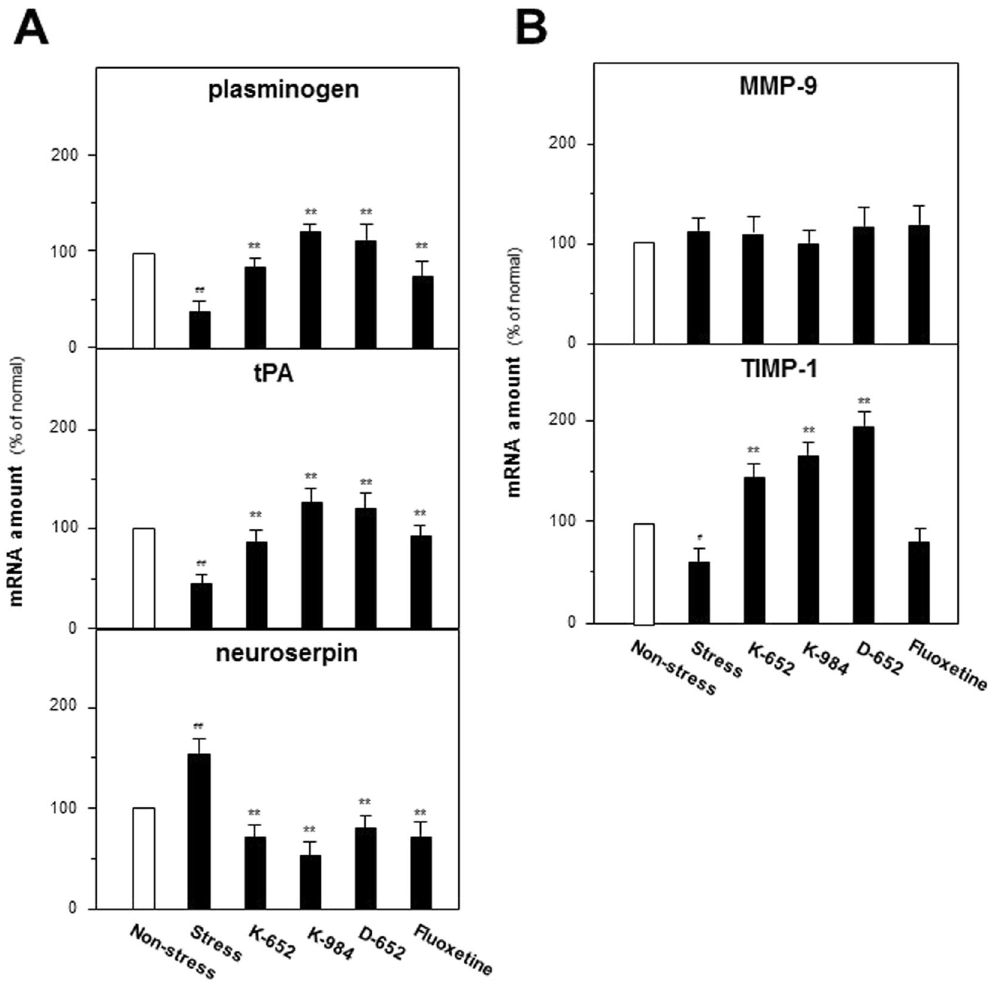
Figure 5. KXS series formulae regulate mRNA expressions of proteins relating to metabolic pathway of neurotrophic factors in hippocampus of CUMS-treated mice. ( A ) The treatment of KXS series formulae and fluoxetine in the mice were same as that in Fig. 1. The hippocampus tissues were collected after one-week treatment and mRNA expression levels of proteins relating to synthesis of neurotrophic factors were analyzed. ( B ) Drug treatment and sample preparations were same as ( A ) and mRNA expression levels of proteins relating to degradation of neurotrophic factors were analyzed. Comparisons between groups were carried out by a one- way ANOVA followed by a post-hoc Bonferroni test. Values are expressed in the percentage of non-stressed group as Mean ± SEM (n = 8). # p < 0.05, ## p < 0.01 (compared with non-stressed group); * p < 0.05, ** p < 0.01 (compared with stressed